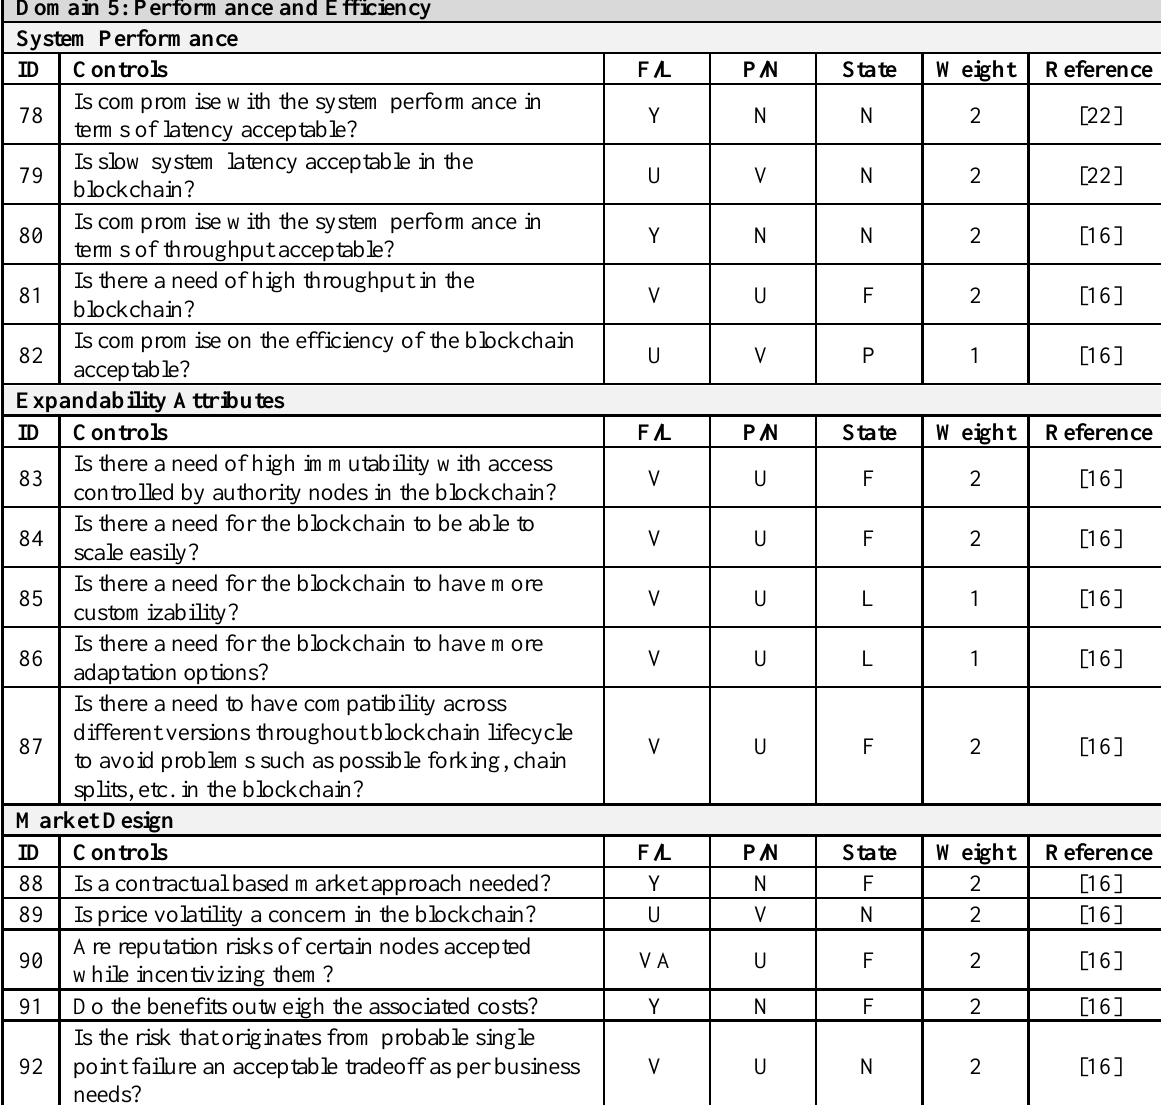
Table 6. Domain 5 of the blockchain applicability framework